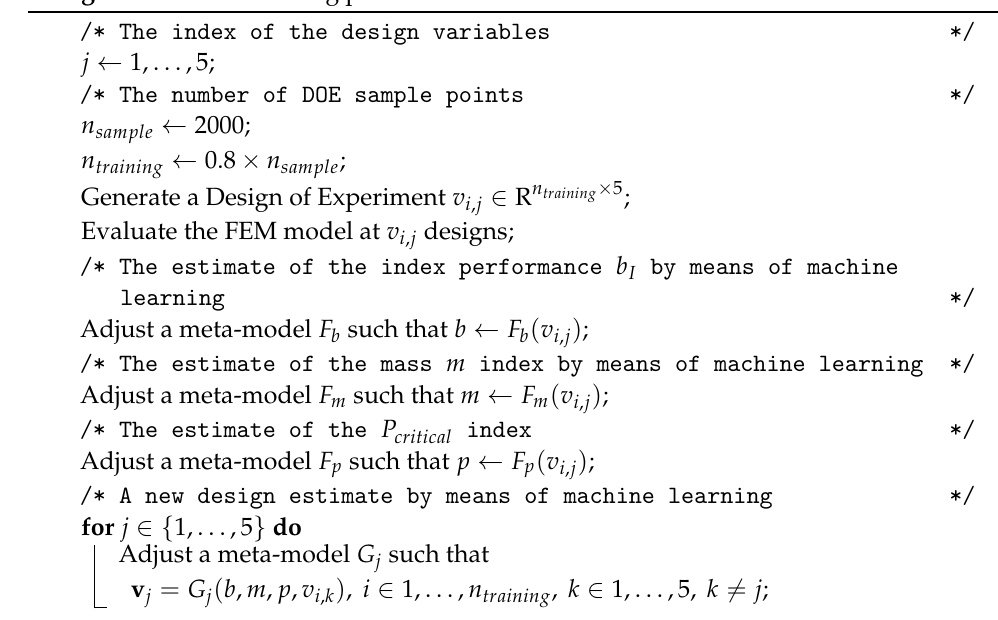
Algorithm 2: The training phase